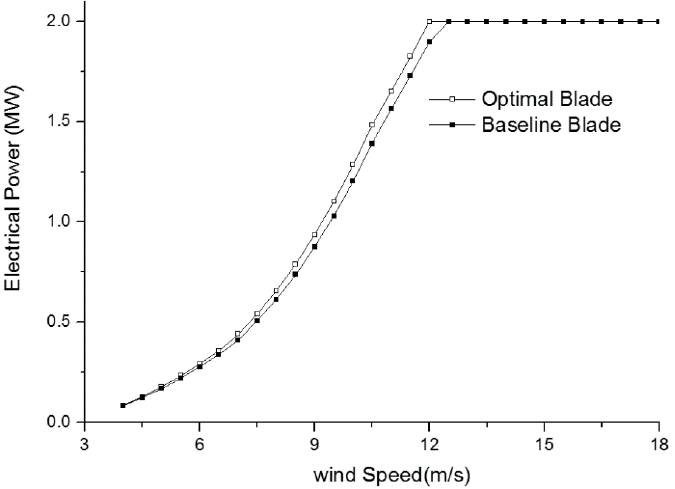
Figure 12. Power curve comparison between the optimal and baseline blades.